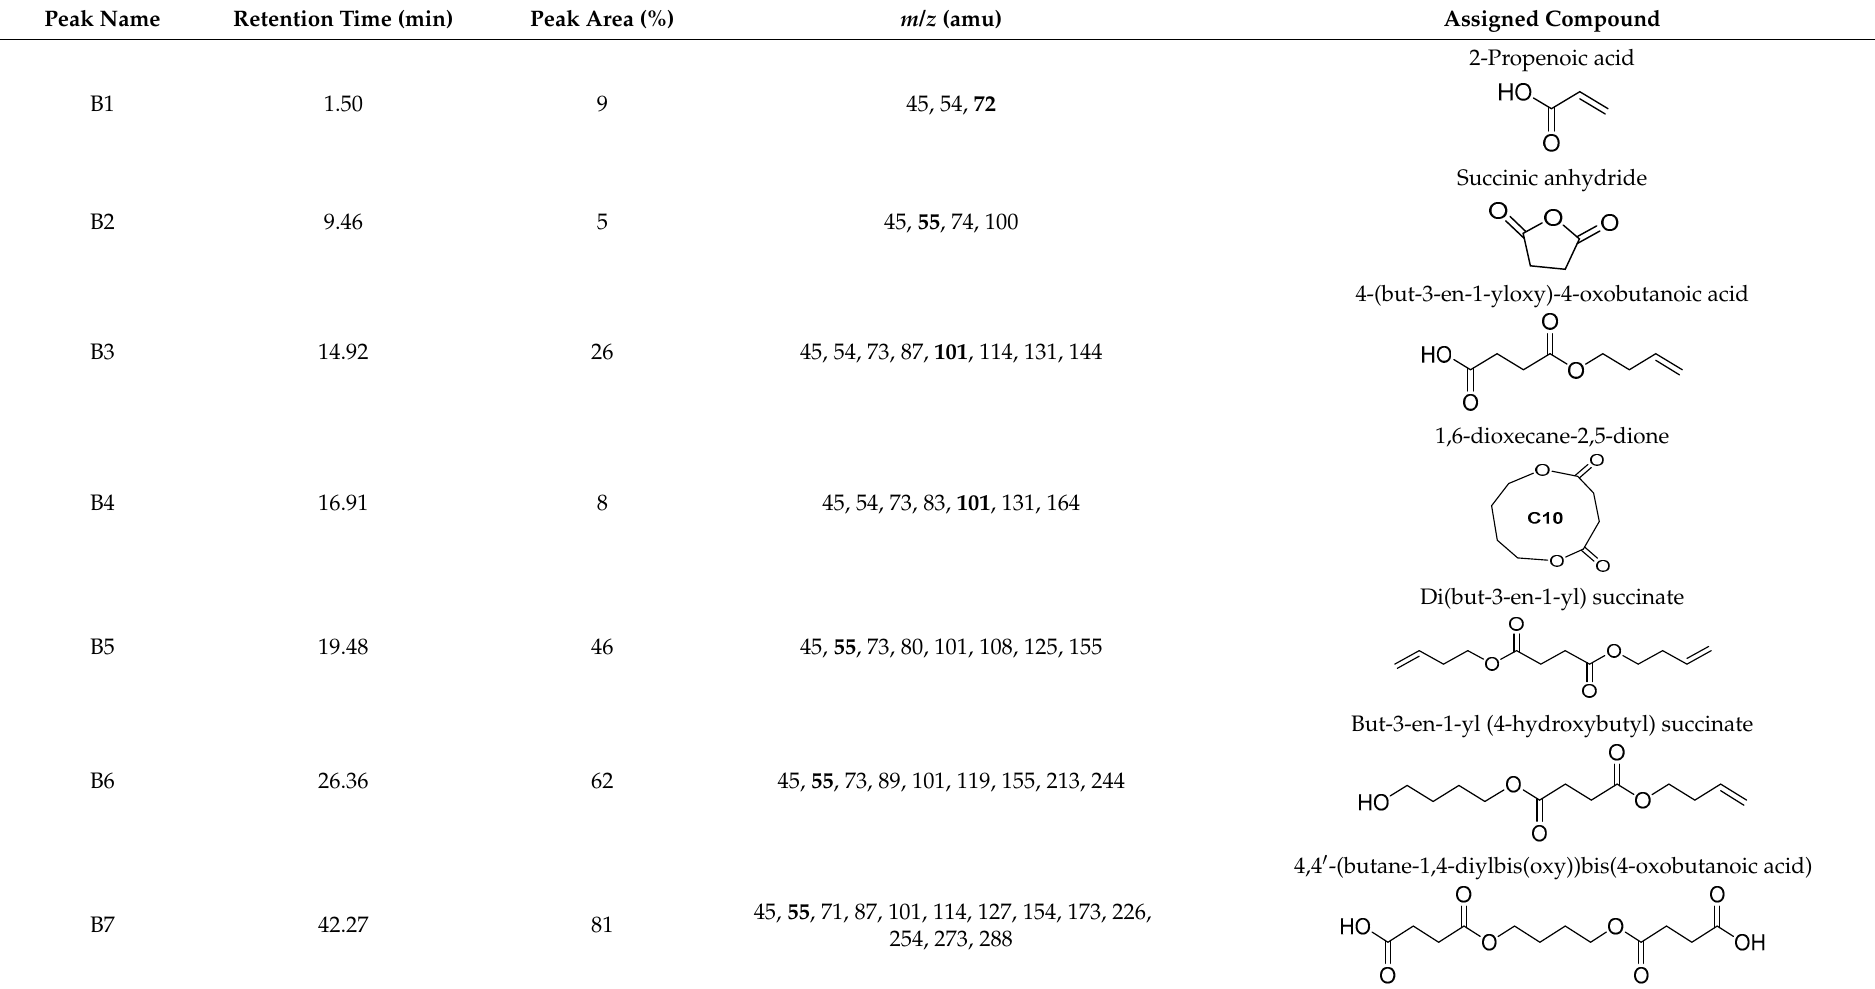
Figure 3. Mass spectra of major decomposition products of PESu. Table 4. Thermal decomposition products of PBSu.